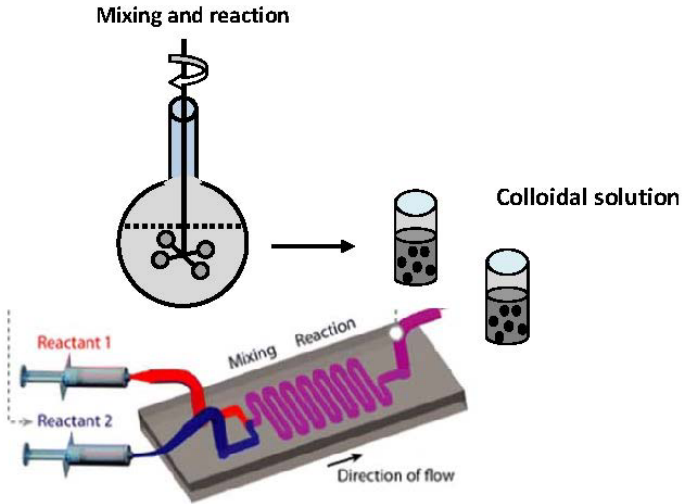
Figure 1. ( a ) Synthesis of nanoparticles through the traditional “flask method”; and ( b ) microfluidic